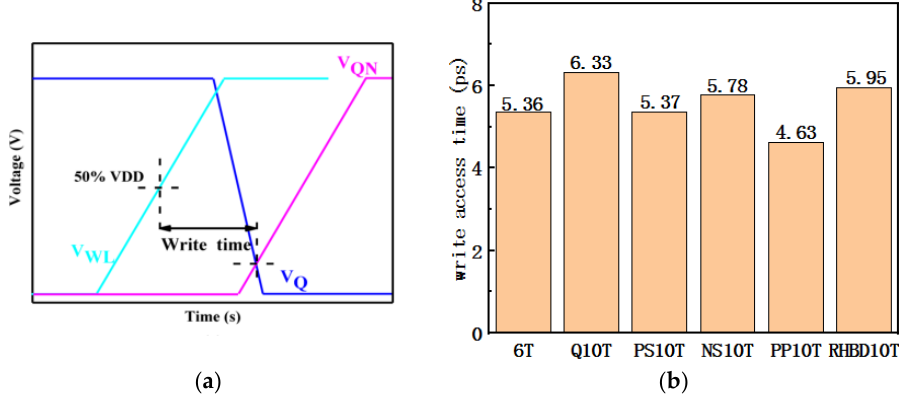
Figure 4. Write access time. ( a ) Measuring method. ( b ) Write access time comparison.